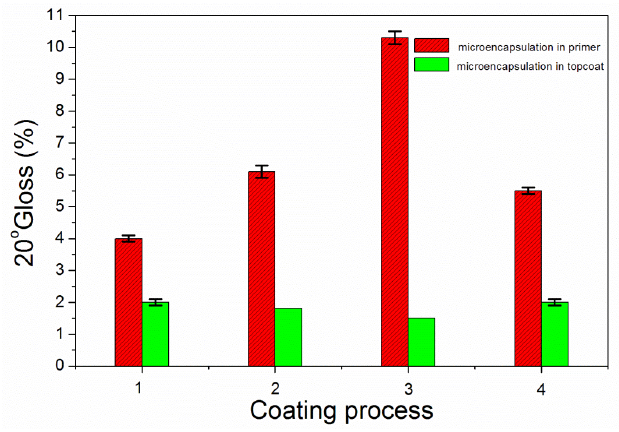
Figure 9. Gloss variation of coating at 20 ◦ incident angle (samples 1–4 from Table 1).